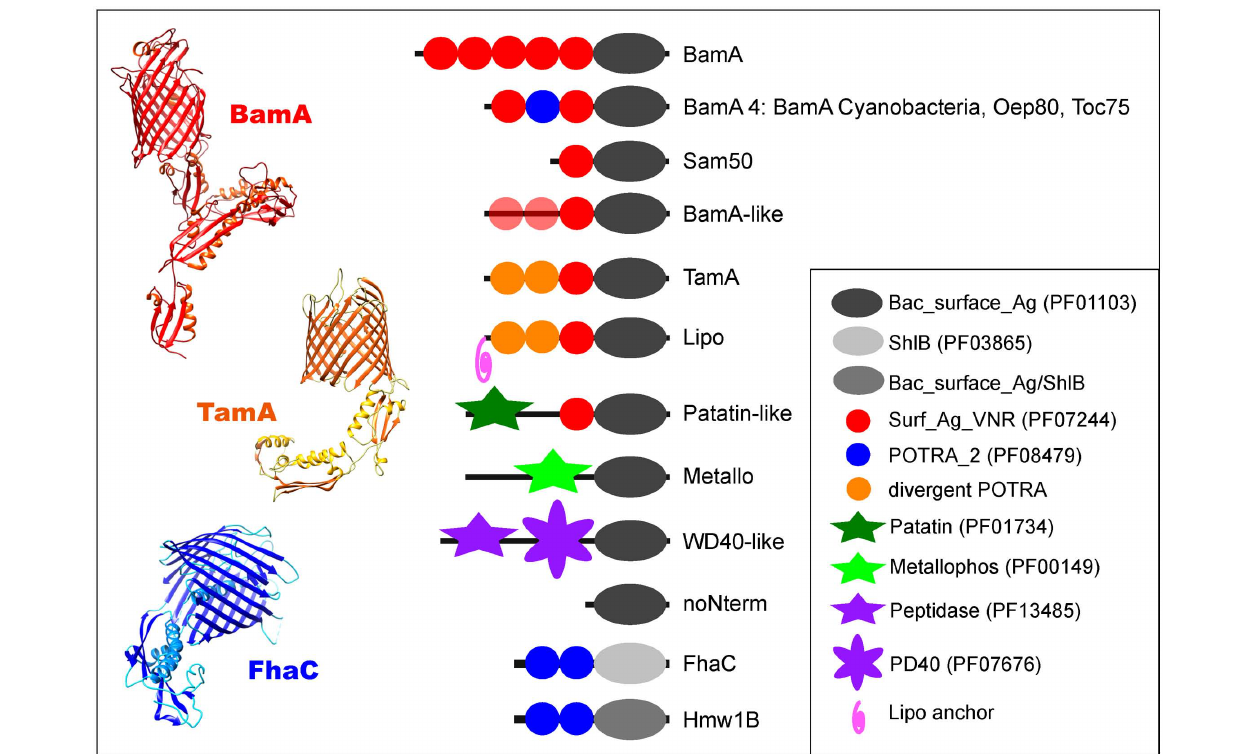
the BamA subfamily. Also shown are the crystal structures for the three known exemplars: BamA (PDB 4K3B; Noinaj etal., 2013),TamA (PDB 4C00; Gruss etal., 2013) and FhaC (PDB 2QDZ; Clantin etal., 2007). In each case the POTRA domains can be seen emanating from the N-terminal region of the barrel